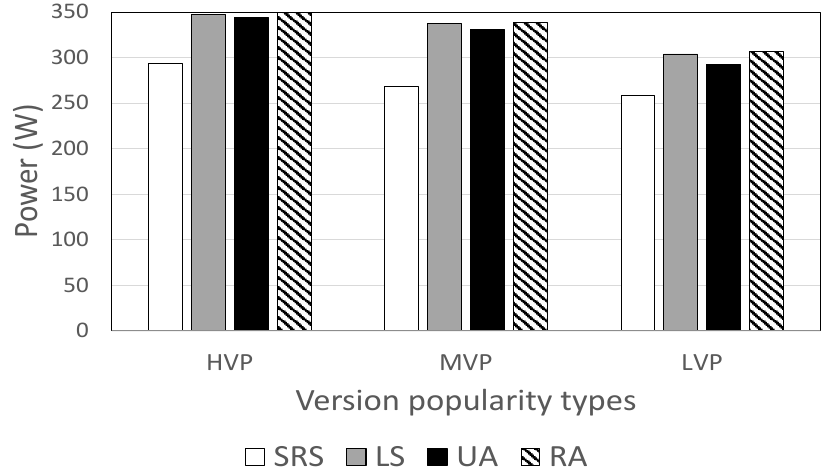
Figure 5. HDD power consumption against version popularity